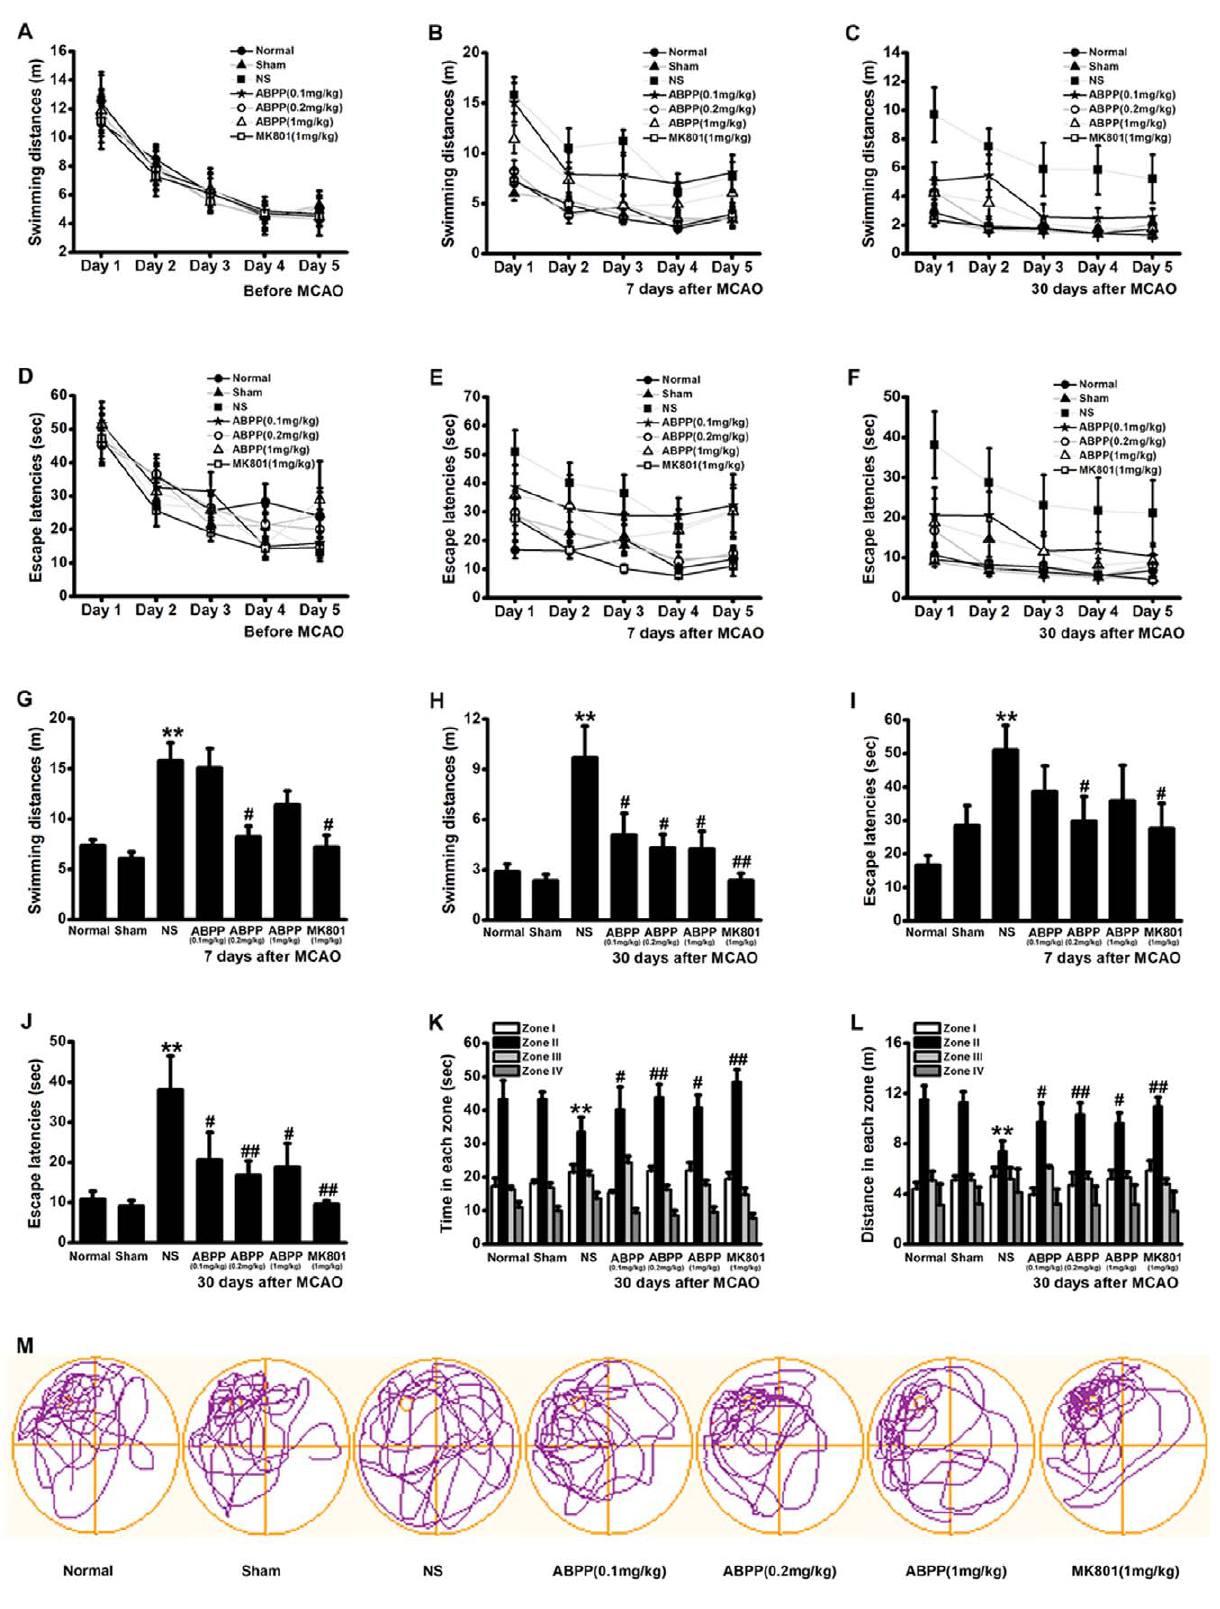
Figure 5. Effect of ABPP on the spatial learning and memory impairments. Swimming distances observed during 5 consecutive days of training on the MWM before MCAO, at 7 th and 30 th day after MCAO (A, B, C). Escape latencies seen during 5 consecutive days of training on the MWM before MCAO, at 7 th and 30 th day after MCAO (D, E, and F). Swimming distances observed at 5 th day of the training (G, H). At the same time, escape